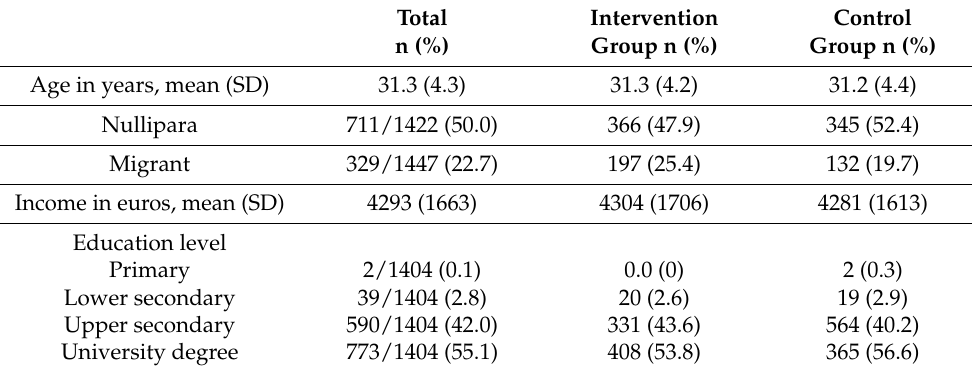
Table 1. Demographic variables of study participants.